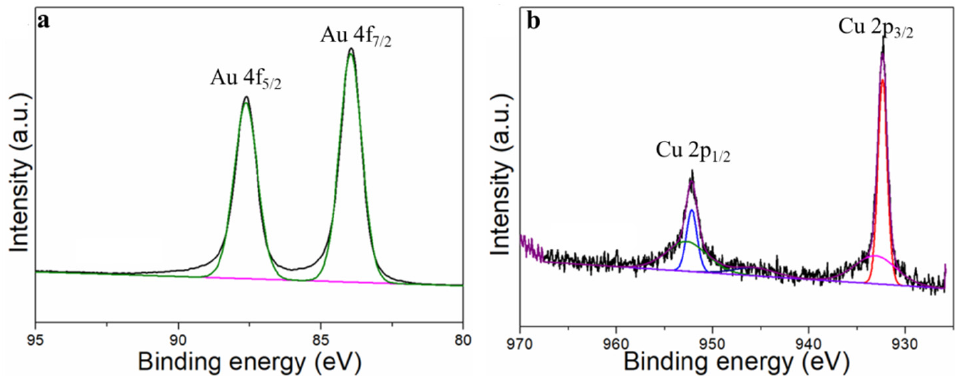
Figure 11. The XPS of Au 75 Cu 25 /C after the stability test. ( a ) Au and ( b ) for XPS data.